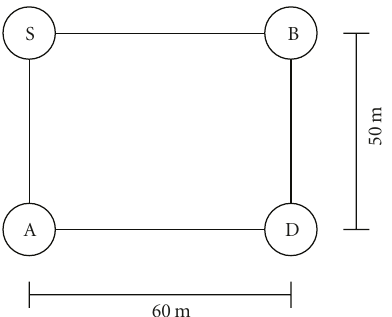
Figure 11: Experimental topology.